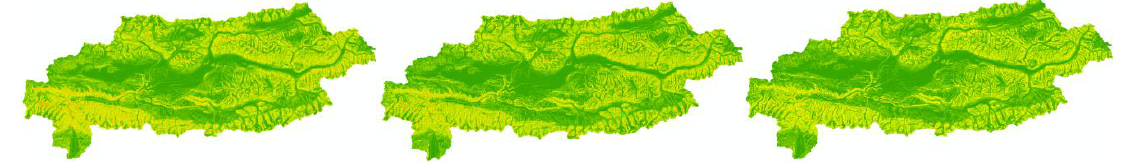
Figure 3. Slope graphs extracted from different data sources （ left: ZY3 DSM; middle:SRTM; right: ASTER